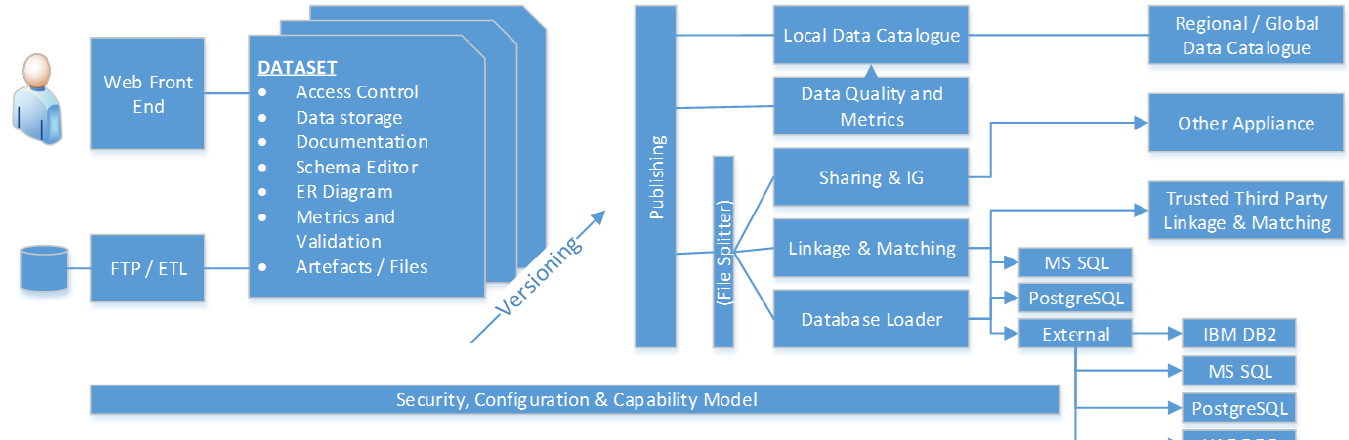
Figure 2: The National Research Data